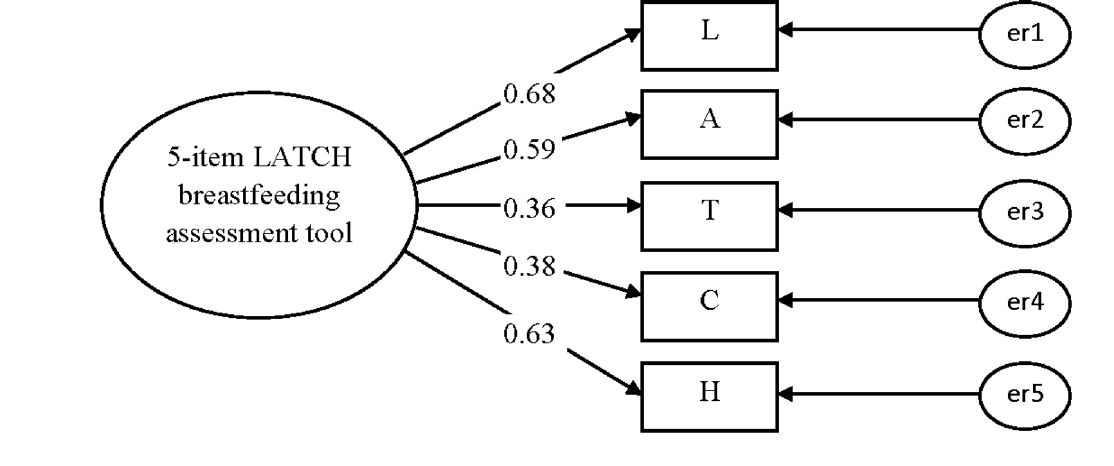
Fig 3. Confirmatory factor analysis for the 5-item LATCH breastfeeding assessment tool among caesarean delivered women (n = 238). Fit indices: GFI=0.961; AGFI=0.883; IFI=0.889; TLI=0.772; CFI=0.886; RMSEA=0.125.